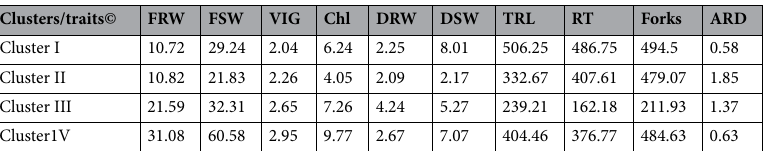
Table 4. Cluster means for seedling traits in maize stock of 71 inbreds under water deficient stress condition. ©FRW (g) fresh root weight, FSW (g) fresh shoot weight, VIG vigour, Chl (µmol/m 2 ) chlorophyll content, DRW (g) dry root weight, DSW (g) dry shoot weight, TRL (cm) total root length, RT number of root tips, ARD (mm) average root diameter.